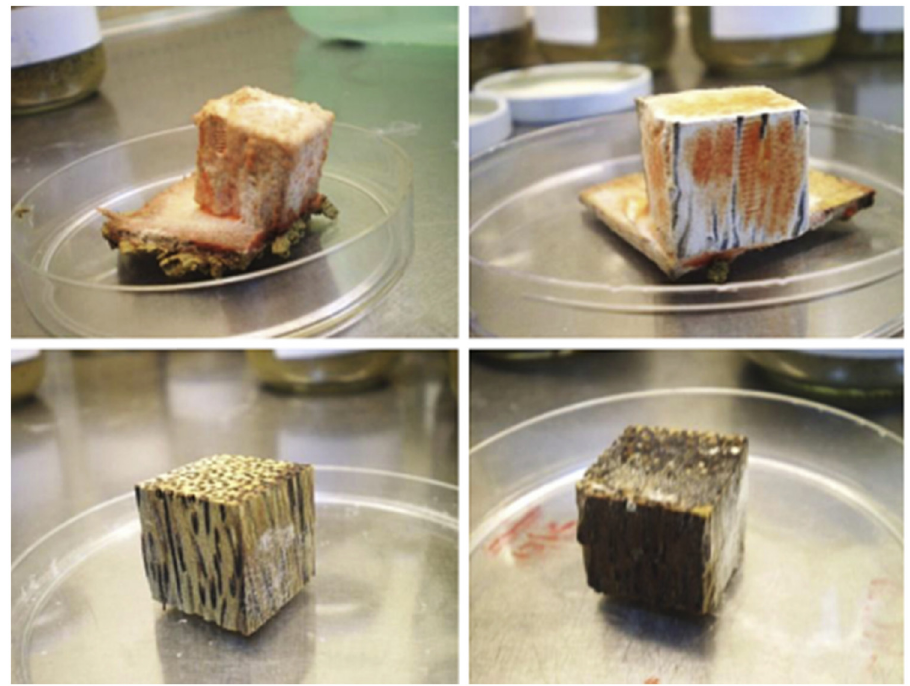
Figure 9: OPW after the end of the decay test. Top left: untreated OPW; top right: treated OPWD - 0%; bottom left: treated OPWD - 25%; and bottom right: treated OPWD - 50% [ 76 ]